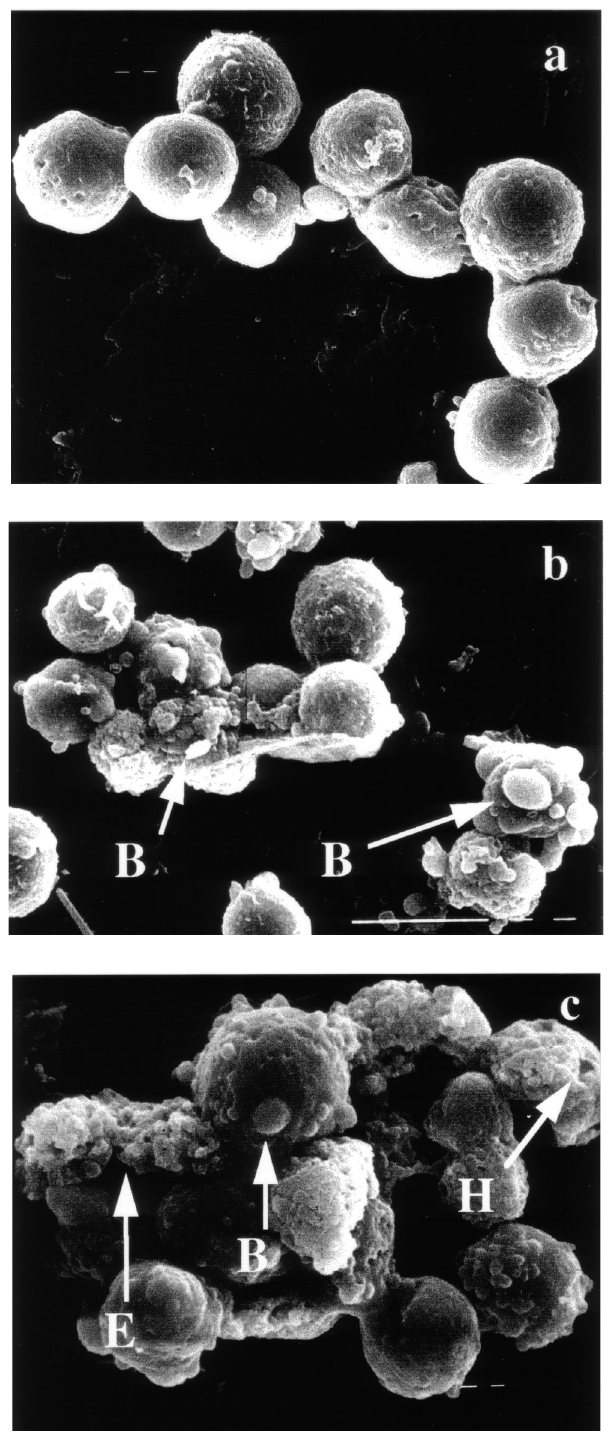
Figure 3: Surface ultrastructural characteristics of BB-88 cells treated with or without tamoxifen as depicted under the SEM. (a) Control BB-88 cells at 48 hours ( × 2400). (b) Tamoxifen treated BB-88 cells ( 24 hours, 10 µ g/ml) showing clumping, cell shrinkage, and membrane blebbing (B) ( × 3000). (c) BB-88 cells treated with tamoxifen ( 48 hours, 10 µ g/ml) showing clumping, cell membrane blebbing (B), holes (H), and cytoplasmic extrusions (E) ( ×